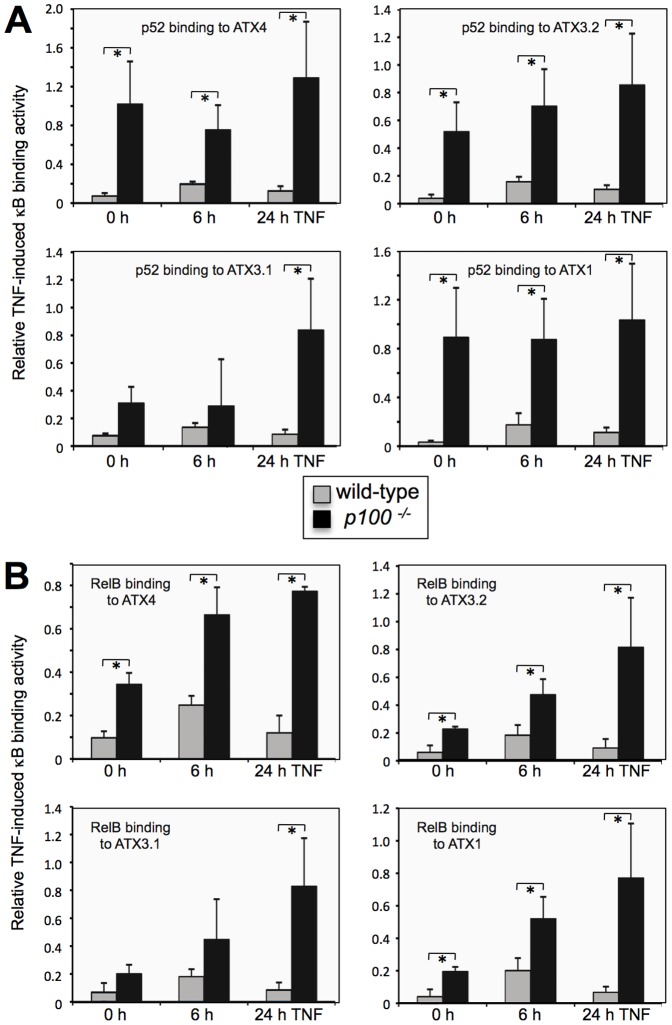
Lack of p100 cooperates with TNF to increase binding of p52 and RelB to the κB elements in the Enpp2/Atx promoter.Wild-type and p100−/− primary MEFs were stimulated with recombinant murine TNF (20 ng/ml) for 6 and 24 h or were left untreated and subsequently nuclear proteins were isolated. In vitro binding of NF-κB subunits p52 (A) and RelB (B) to the κB target sites in the Enpp2/Atx promoter was determined as in Figure 2. Data are presented as mean values ± SD from n = 3 independent experiments. Significant differences (P≤0.05) in p52 and RelB binding were calculated by Student's t-test and are indicated (*).